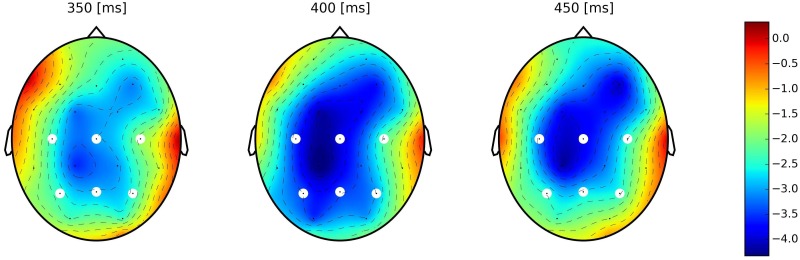
Scalp plots of difference between homograph unrelated and homograph related groups for long experimental version.Each scalp plot represents the mean of 50 ms time window (from left to right: 350 to 400 ms, 400 to 450 ms and 450 to 500 ms accordingly). A persistent negativity (N400 effect—N400hu−N400hr) is observed in all time windows.